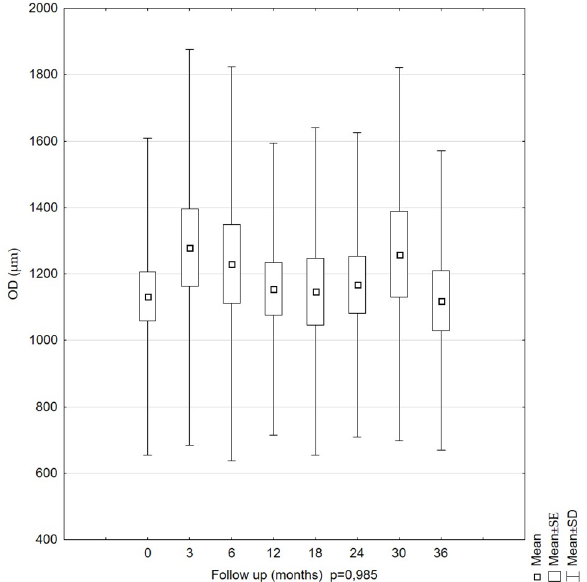
Figure 6. Mean values of the outer diameter (OD) parameters in LMH patients during the 36-month follow-up period. The OD showed no statistically significant changes over this period.